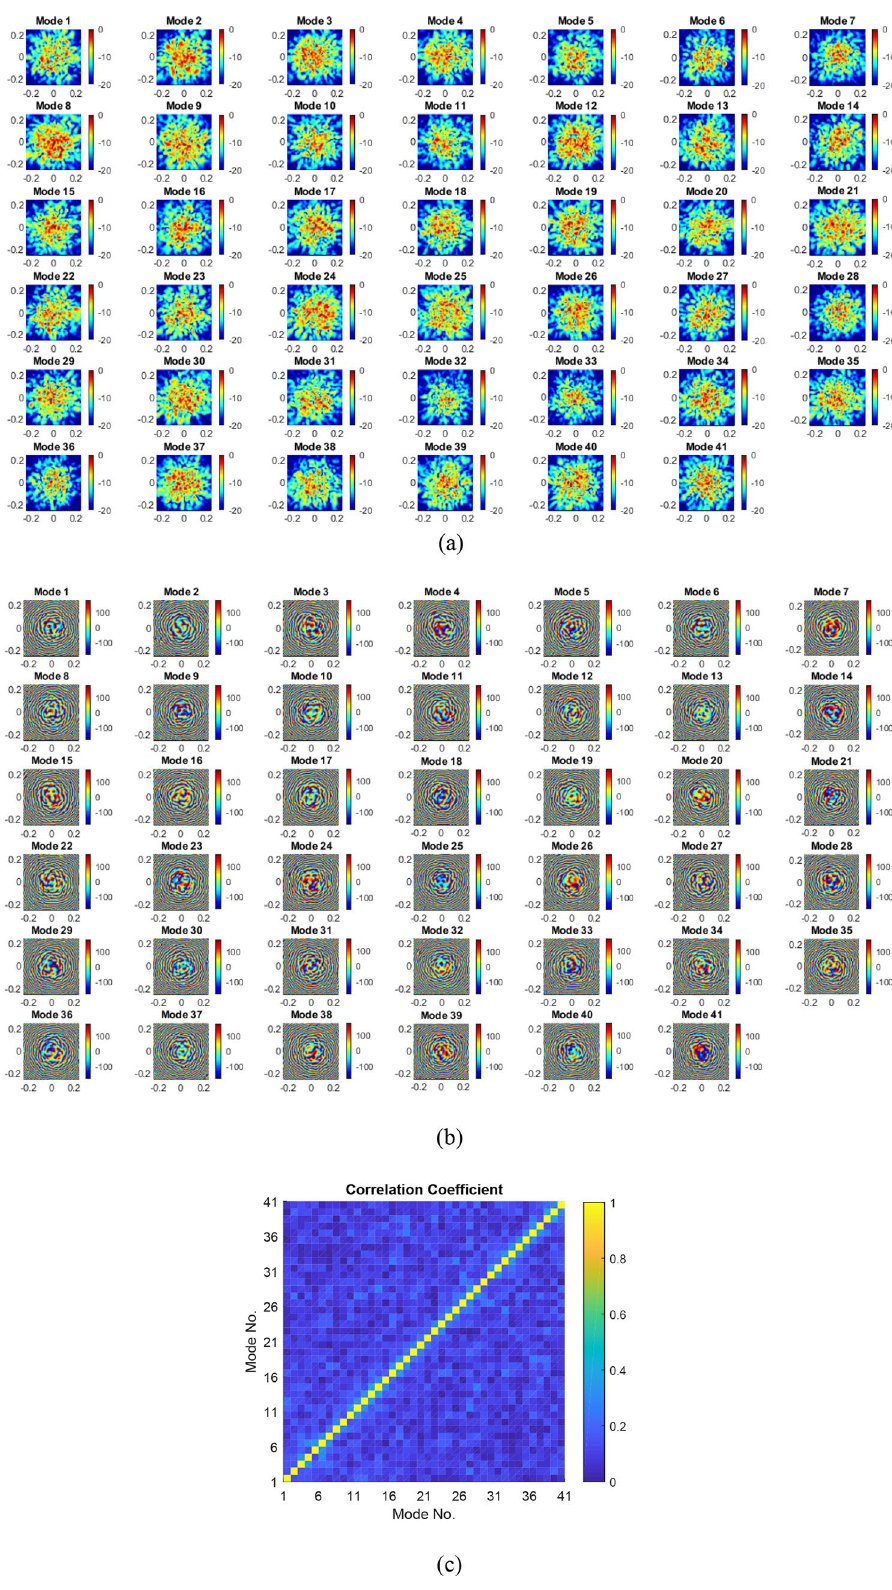
Figure 7. Measured near-field contour plots ( a ) magnitude, ( b ) phase, ( c ) correlation coefficient surface plot for N = 41